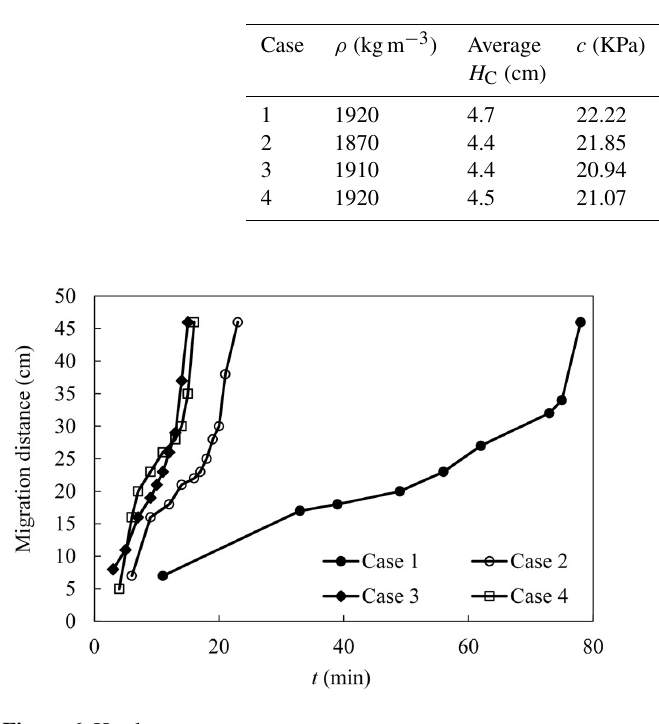
Figure 6. Headcut retreat process.